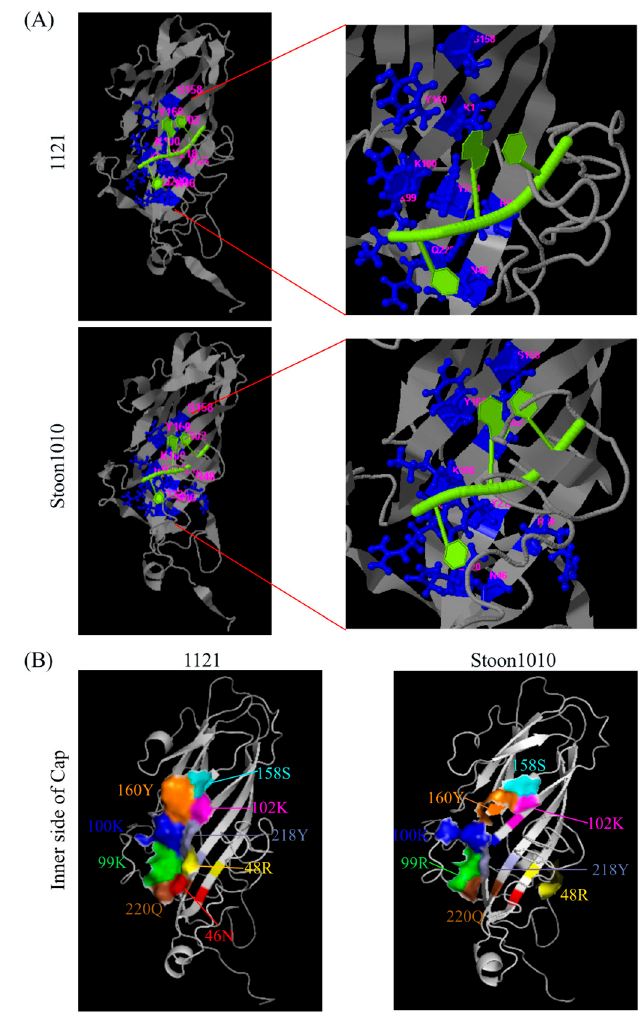
Figure 15. Binding PCV2 Cap protein to the nucleic acid. ( A ) Predicted models of PCV2 Cap protein binding to nucleic acid. Ribbon diagram of the PCV2 capsid protein are shown with a full view (left) and a zoomed view (right). Binding residues are shown in blue balls and sticks, and are labelled with magenta; predicted binding nucleic acid is shown in green/yellow. ( B ) Location of amino acids that are at the predicted binding sites. Different color codes were used for different amino acid sites, and the same color was used for the same amino acid site across strains 1121 and Stoon1010. The 3D structures of capsid were generated using I-TASSER server and displayed with PyMOL.